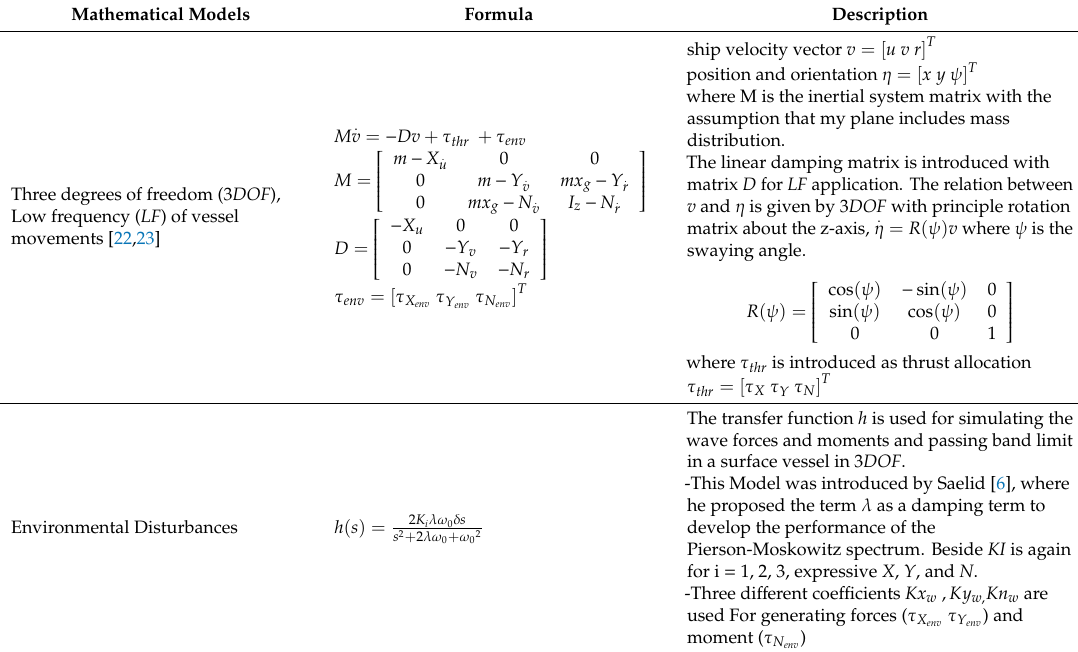
Table A1. Summary of DP mathematical